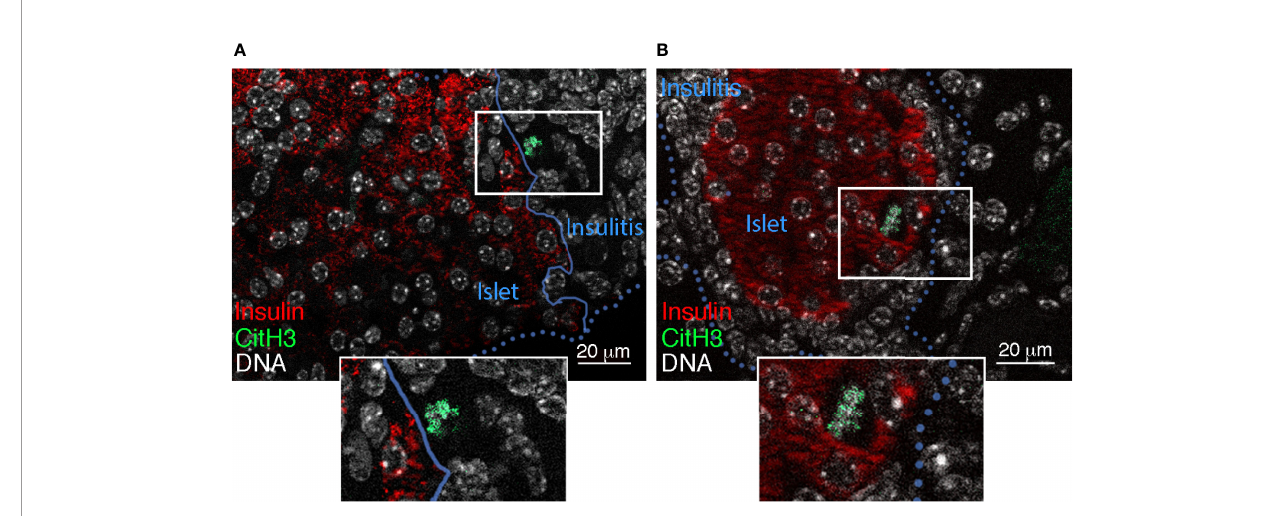
FIGURE 1 | Islet-associated CitH3 in NOD pancreas. Immuno fl uorescence detection of insulin (red) (48) and CitH3 (green) (15) (using AF488 donkey anti-rabbit Ig) in pancreas sections from (A) 4 week-old and (B) 10-12 week-old female NOD mice. Blue unbroken and dotted lines de fi ne the islet border in (A) and insulitis, respectively. DNA is labelled using Hoechst 33342